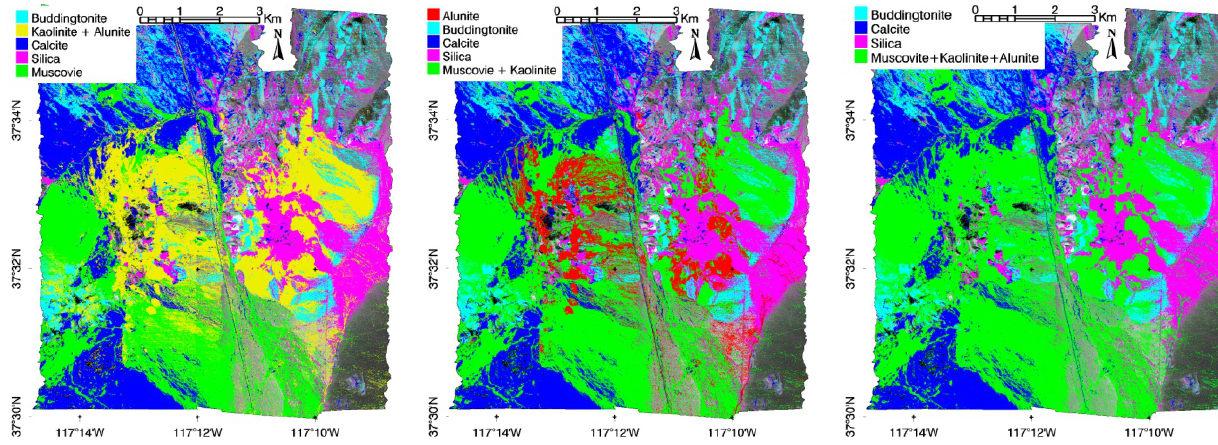
Figure 6. AVIRIS MTMF mineral maps at 7.5 m spatial resolution for several different combinations of similar minerals ( Left ) Kaolinite and Alunite combined ( Center ) Kaolinite and Muscovite combined ( Right ) Kaolinite, Alunite, and Muscovite combined. Note the significant loss of detail regarding specific important mineral patterns mapped by AVIRIS (and the simulated WV-3 using all the minerals) in Figure 5.